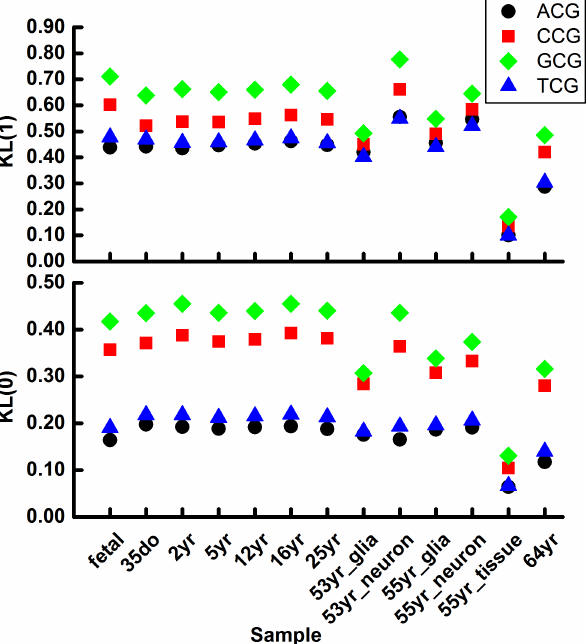
Fig 4. Methylation variation (above) and demethylation variation (below) of trinucleotide N 5 CG of chromosome 1 in human brain samples.